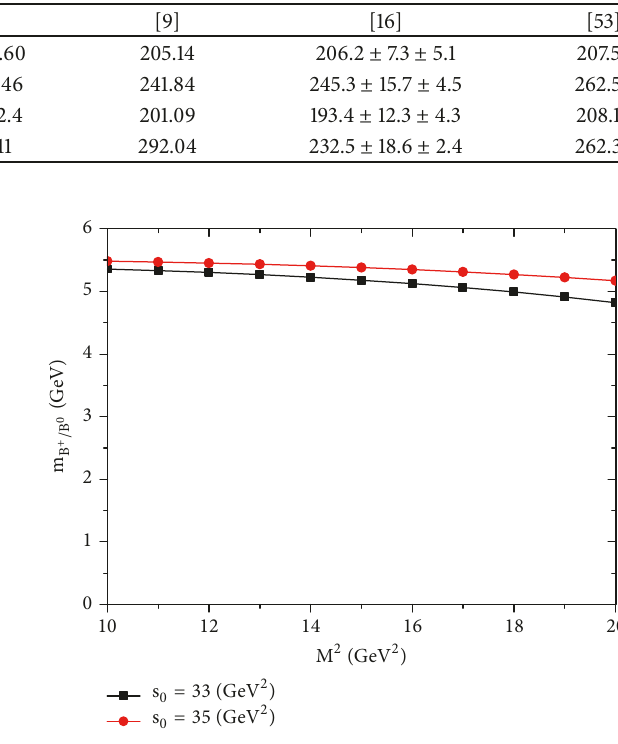
Figure 3: Borel parameter dependence of the 𝐵 + /𝐵 0 masses.